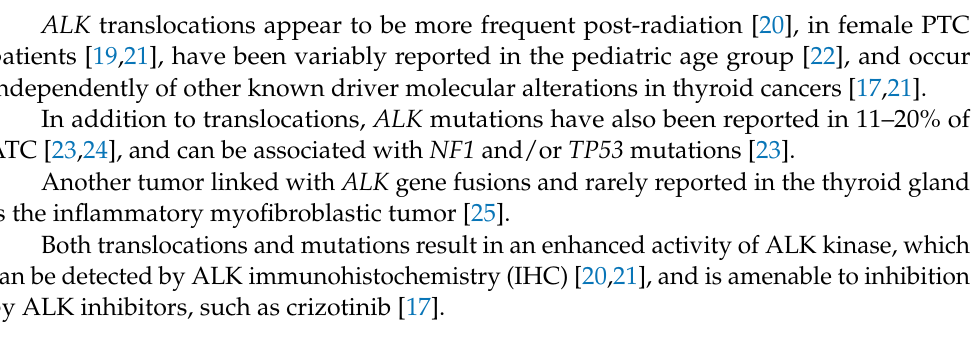
Figure 2. Genetic evolution of differentiated thyroid cancers. PTC, papillary thyroid carcinoma; FTC, follicular thyroid carcinoma; OCA, oncocytic carcinoma; and ATC, anaplastic thyroid